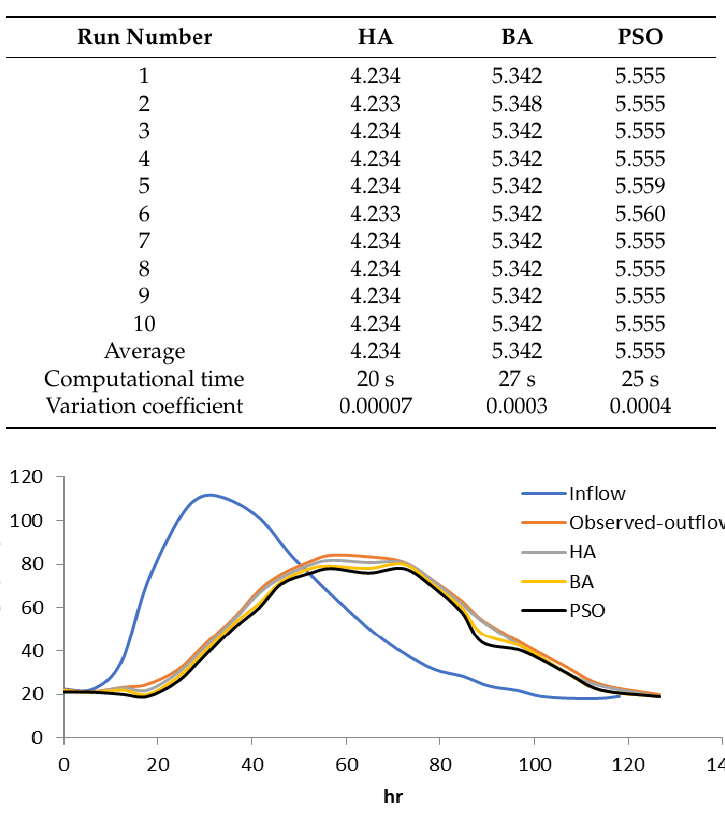
Table 4. Ten random results for average solutions for Wilson flood.